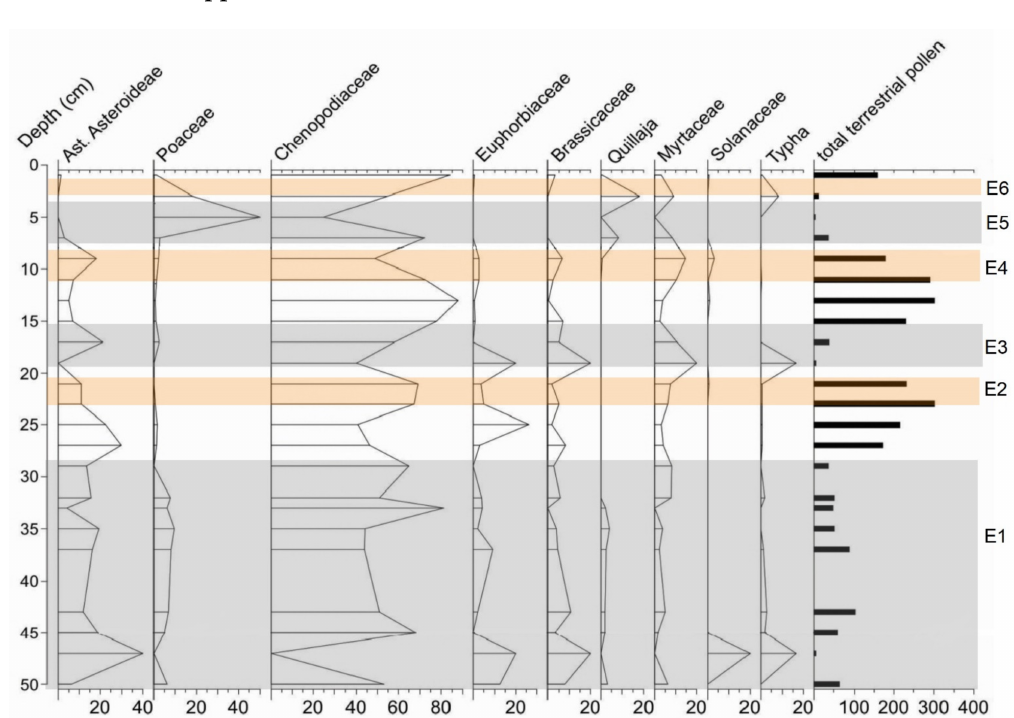
Figure A2. Abundance of pollen species in the different marine (grey) and continental (brown) deposits.